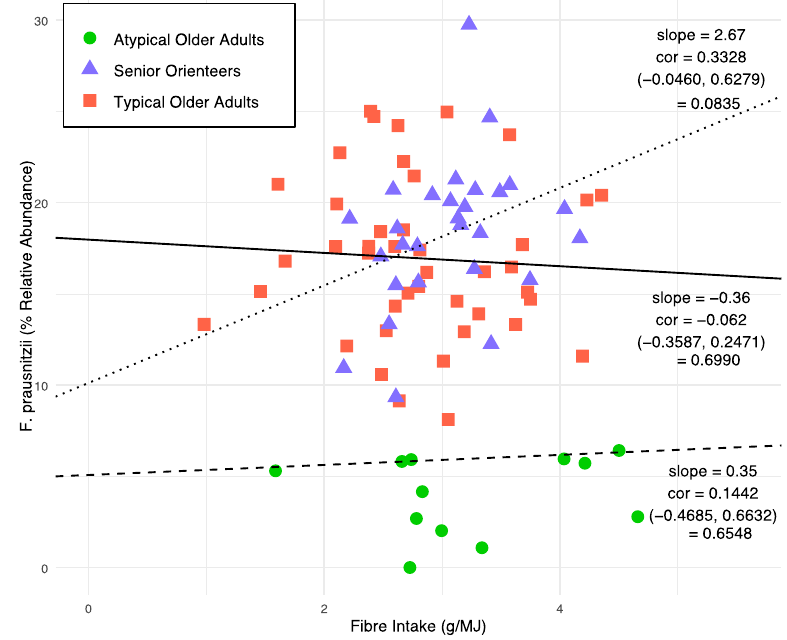
Figure 8. Comparison of covariates when older adults are stratified for typical and atypical. Atypical older adults are defined as samples outside of the confidence ellipse area in Figure 7. Statistically significant di ff erences are marked with an asterisk. ( A ) Macronutrient intake measured by energy percentage (E%). ( B ) Fibre measured by grams per megajoule. ( C ) Anxiety and depression scores. ( D ) Mean score of gastrointestinal symptoms. ( E ) Representation of proportion of subjects with medications.